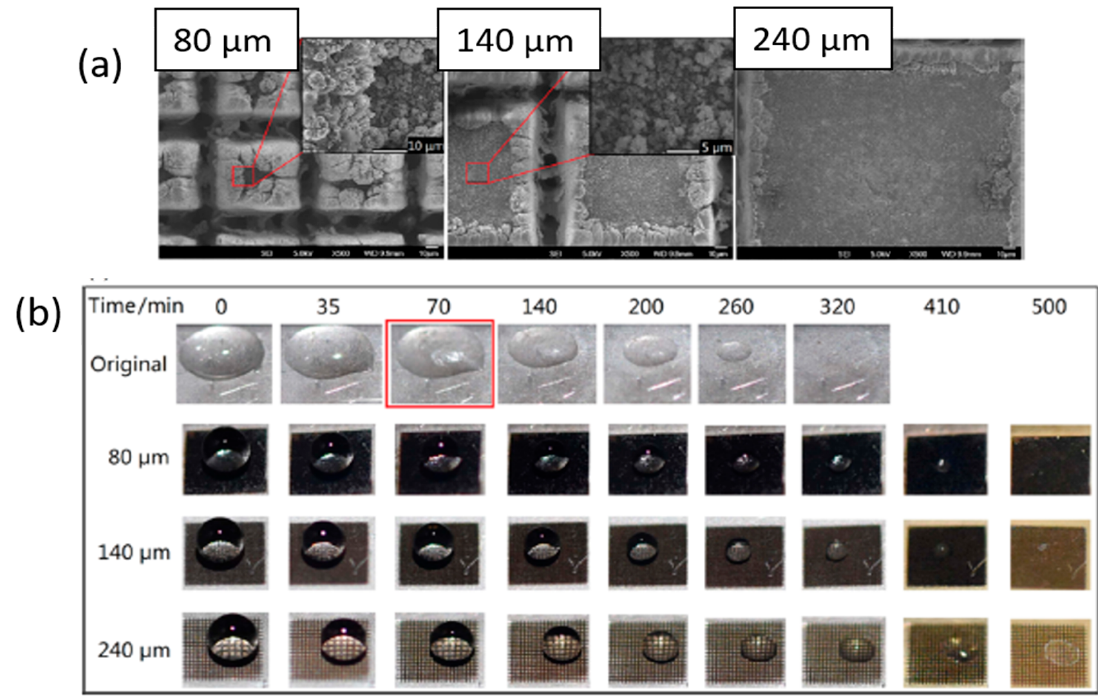
Figure 8. ( a ) Scanning electron microscope images of the stainless steel laser textured samples. Groove pitches: 80, 140, and 240 µ m. In the insets, magnifications of the redeposited aggregates. ( b ) Evolution of the droplet set on the original and laser-machined superhydrophobic surfaces at subzero temperature ( − 8.5 ± 0.5 °C) (Reprinted with permission from [109]).